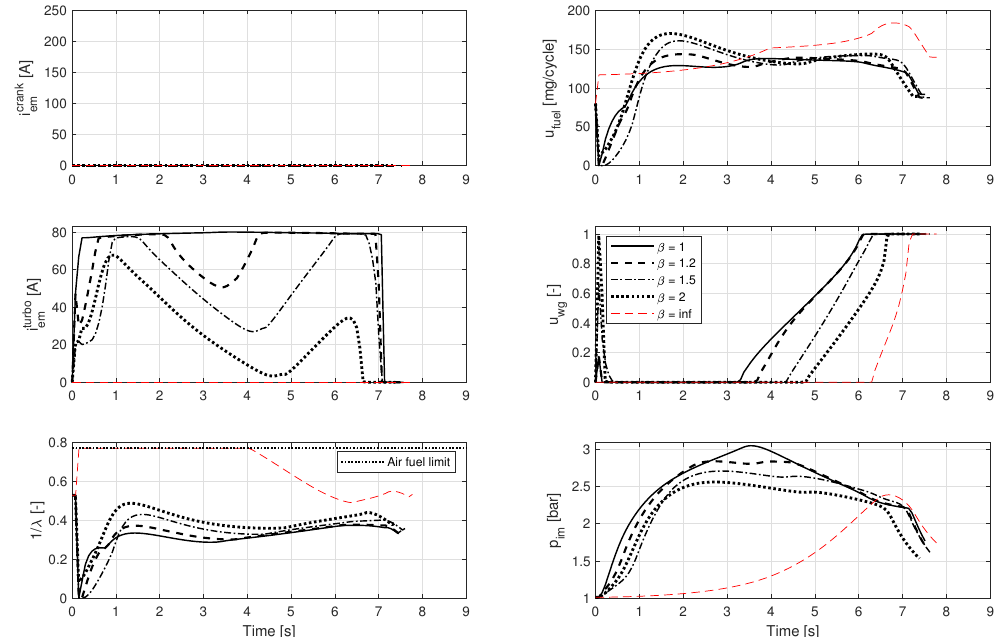
Figure 8. Controls, fuel-air ratio and intake manifold pressure, when the E-turbo is used to support the engine during the